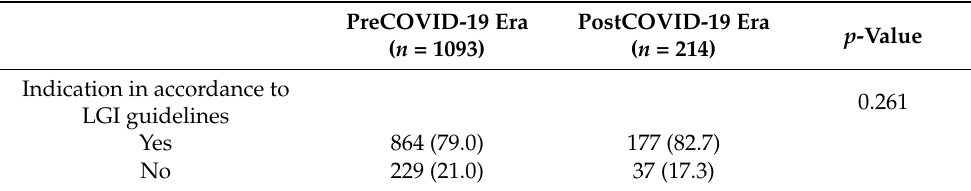
Table 4. Comparison of indications between patients receiving a LGI endoscopy in the preCOVID-19 era and postCOVID-19 era.